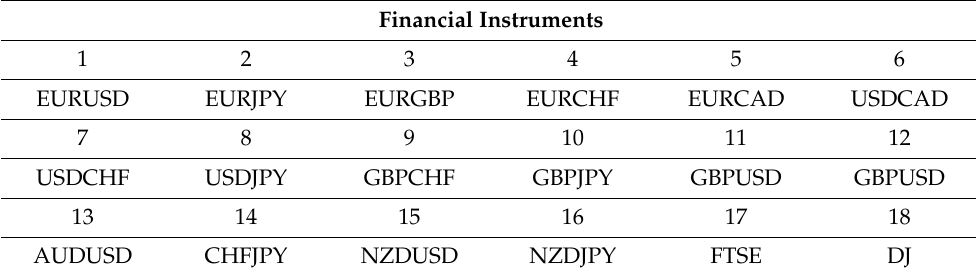
Table 1. Financial instruments and their respective numbers.